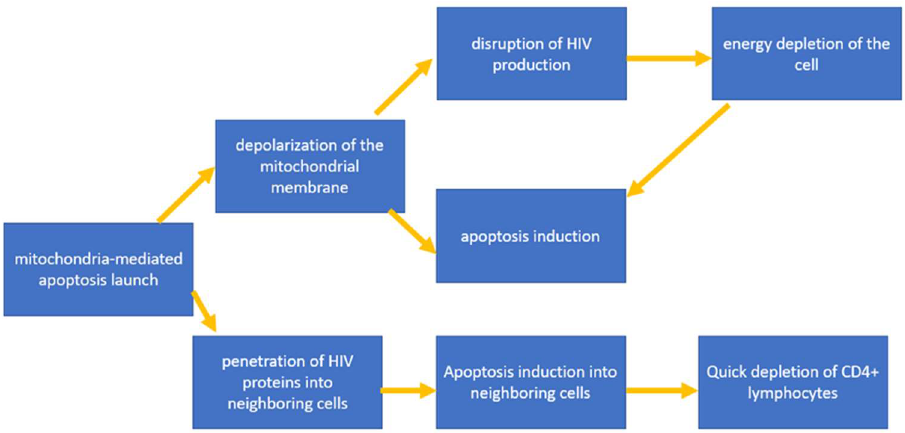
Figure 3. General scheme for triggering mitochondria-mediated apoptosis induced by HIV proteins.